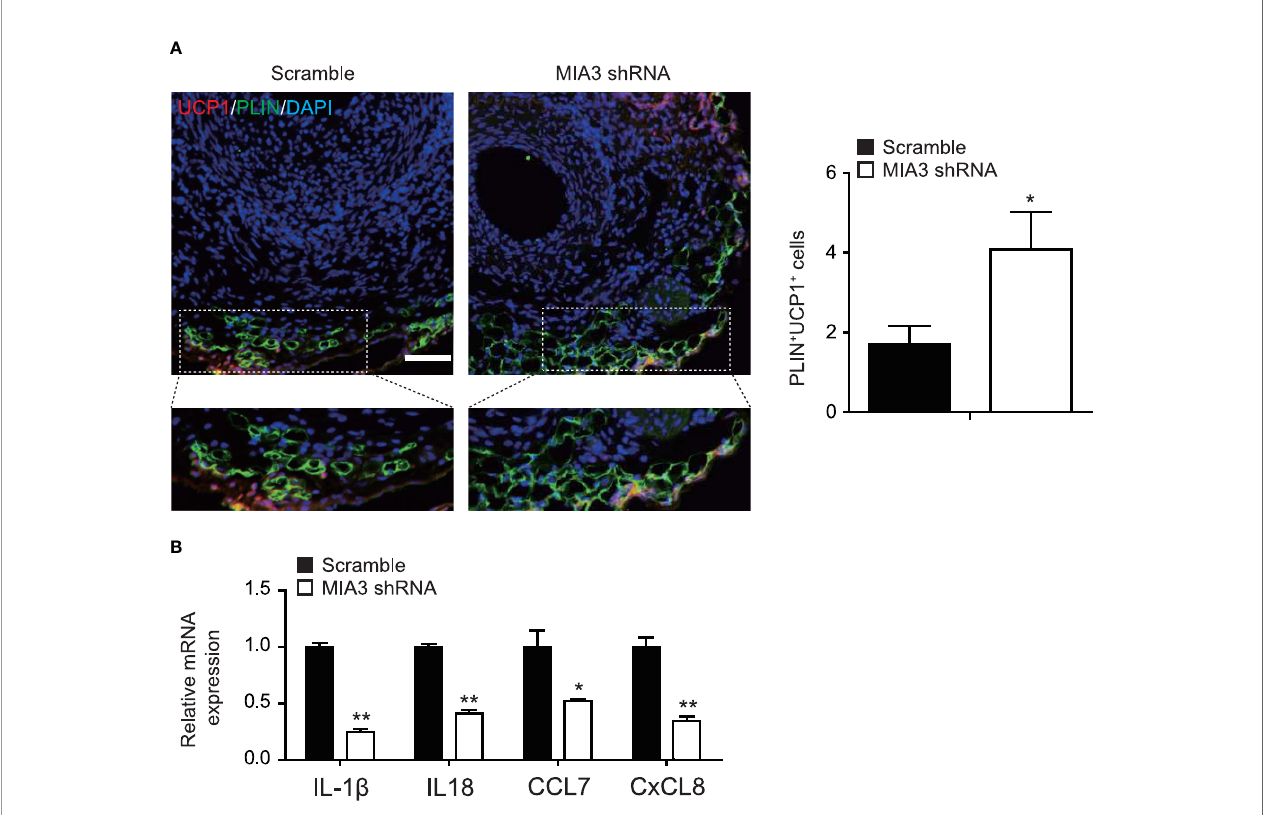
FIGURE 6 | Knockdown MIA3 increases the expression of uncoupling protein-1 in the perivascular adipocytes. (A) Knockdown MIA3 with shRNA lentivirus exhibited signi fi cant increase of PLIN and UCP-1 double-positive cells in the neointima at 28 days after femoral artery wire injury, with representative images (left) and quanti fi cation data (right; n = 5 for each group). Data are represented as the mean ± SEM. * p < 0.05. t -test. (B) Knockdown MIA3 with siRNA in VSMCs signi fi cantly decreased expression of IL-1 b , IL18, CCL7, and CxCL8 by quantitative real-time reserve transcription polymerase chain reaction. Data are represented as the mean ± SEM, n = 3. * p < 0.05, ** p < 0.01, t